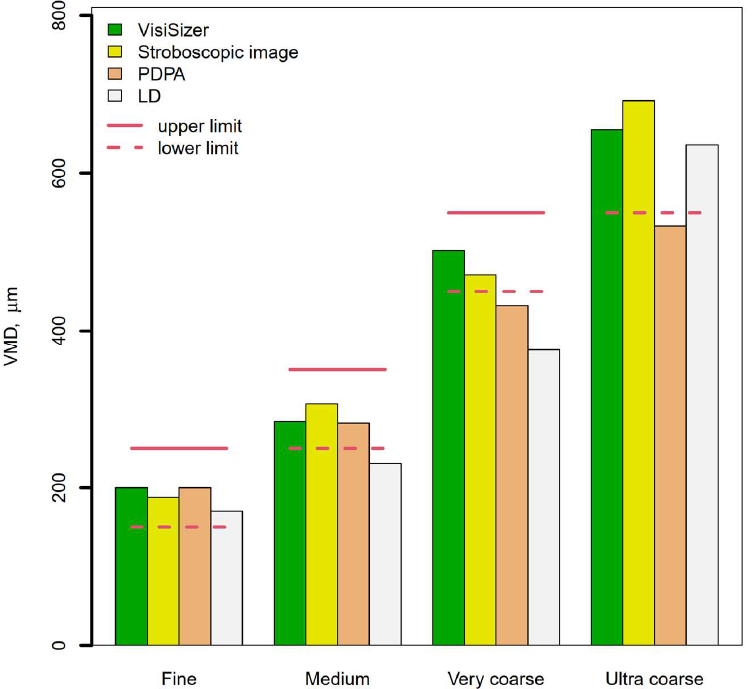
Figure 5. Comparison between non-intrusive measurement methods based on the research of Sijs et al. (2021) [26]. Upper and lower limits refer to the expected range for each spray quality. Overall, the results emphasized how the limitations of each method can influence the droplet size measurements and also the need for selecting the size measurement method to fit the expected range of droplet parameters. In the Belgian study of Nuyttens et al. (2007) [8], the authors compared their PDPA measurements with results from 17 refer- ences for the British Crop Protection Council (BCPC) reference nozzles and deduced that absolute results vary considerably between different investigators depending on the set- tings and type of measuring tool. 5. Intrusive Measurement Methods Various intrusive methods based on image analysis have been used in the literature for spray characterization in agricultural treatments in order to provide accurate infor- mation on droplet size. Among these, in this section, we focus our attention on the use of water-sensitive papers (WSPs) and the liquid immersion (LI) method, which appear to be the most useful. They usually involve the capture of a droplet sample on a solid surface or in a cell containing a special liquid. Then, the drops are photographed or observed with the aid of a camera or microscope. In general, these methods use a light source that is as diffused as possible to illuminate a collection of droplets, followed by software analysis of the images to determine all the droplet spray parameters. These methods, even if intru- sive, have the virtues of simplicity and low cost, but the extraction and collection of rep- resentative droplet samples should be considered. Another aspect to be considered re- gards the resolution of the image, to be chosen according to the size of the particles to be extracted [67,68].